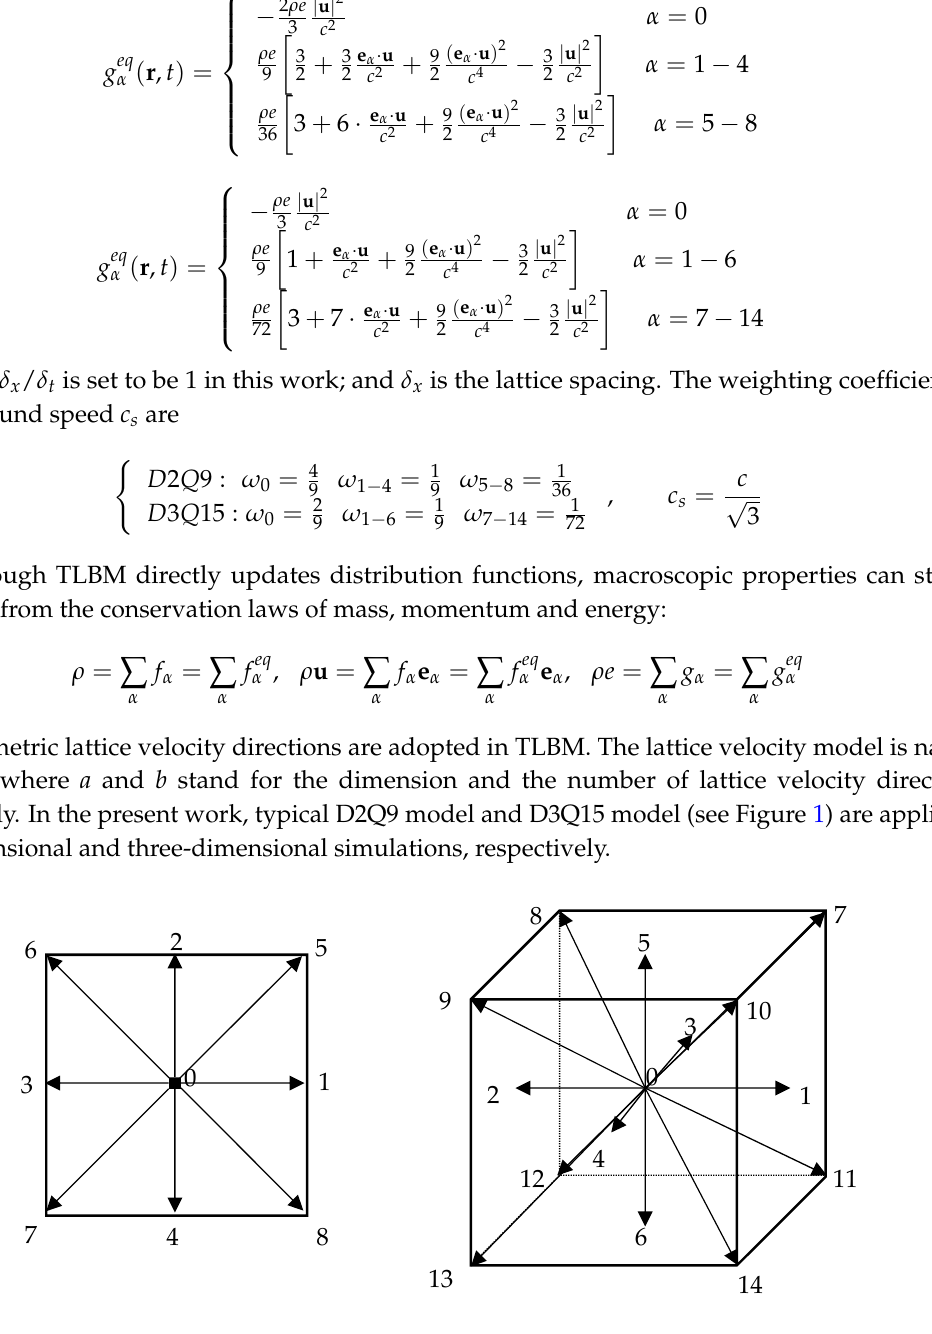
Figure 1. Illustration of D2Q9 and D3Q15 model.